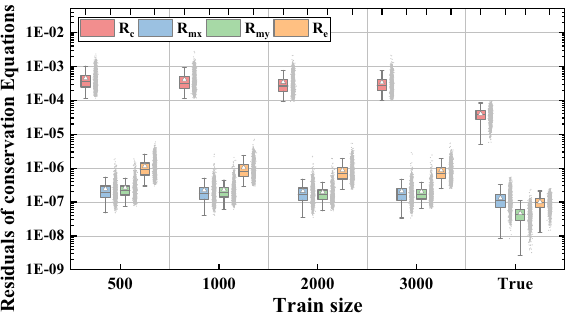
Figure 10. Residuals of conservation equations vs. train size.